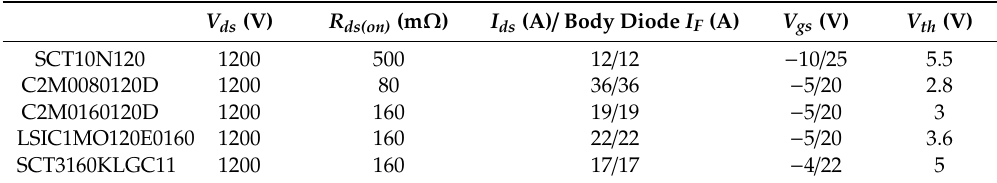
Table 2. Device parameters from the